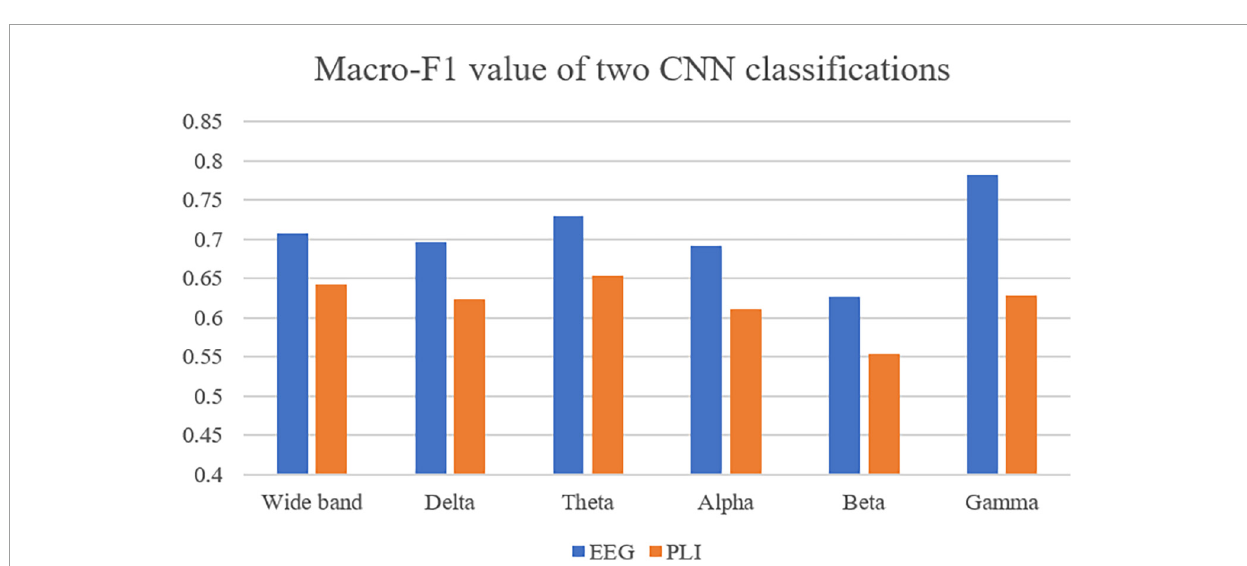
FIGURE10 Use Macro-F1 to evaluate the model obtained from two kinds of data in six frequency